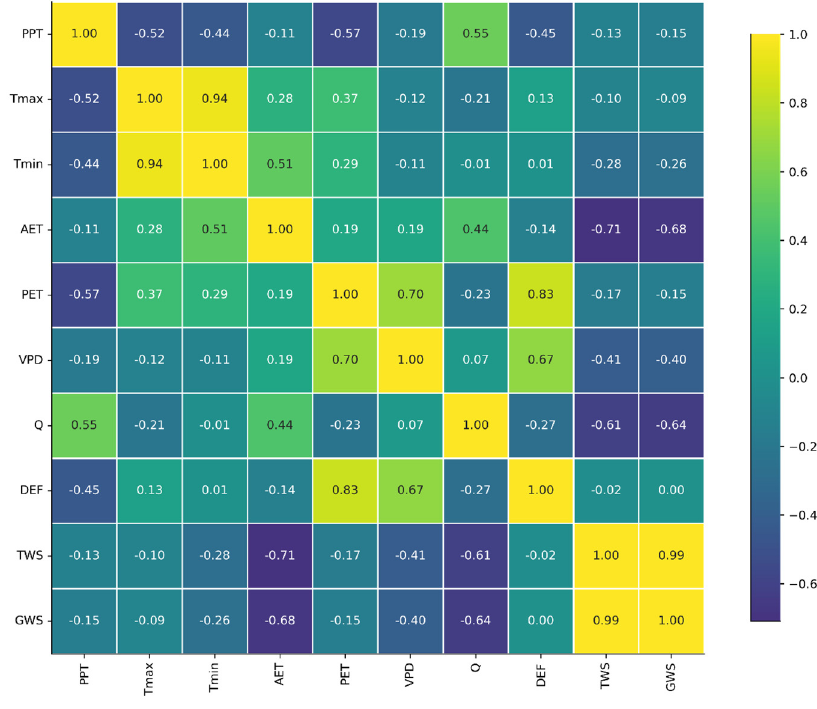
Table 3. Considering water storage variables importance using Boruta algorithm.